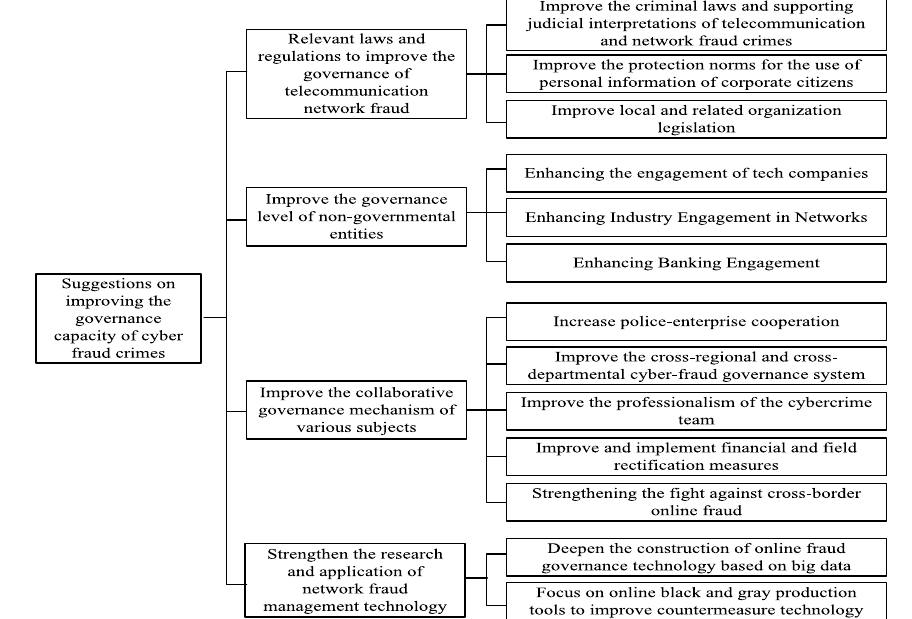
Fig. 14 Suggestions for